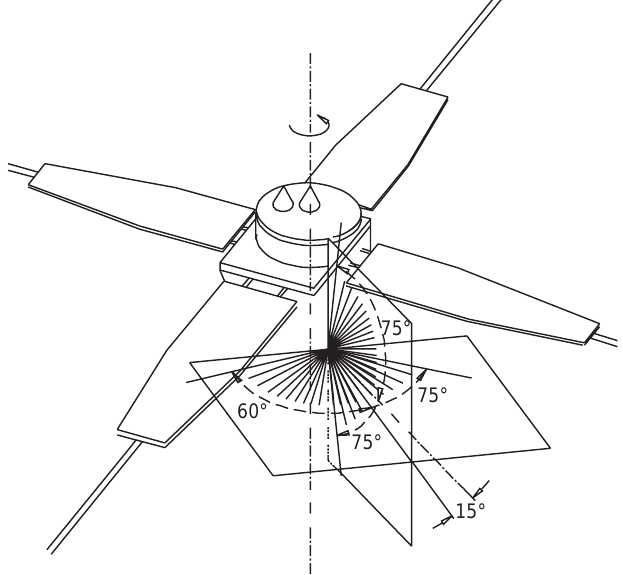
Fig. 2. Geometry of the two analyzers relative to the